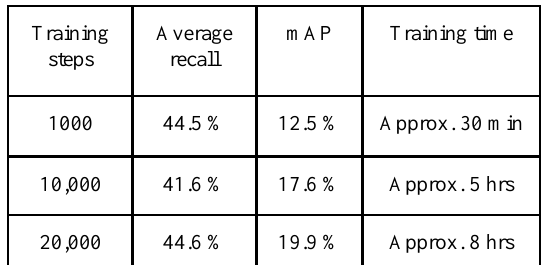
Figure 8. True and false positives (clouds, right) for foams